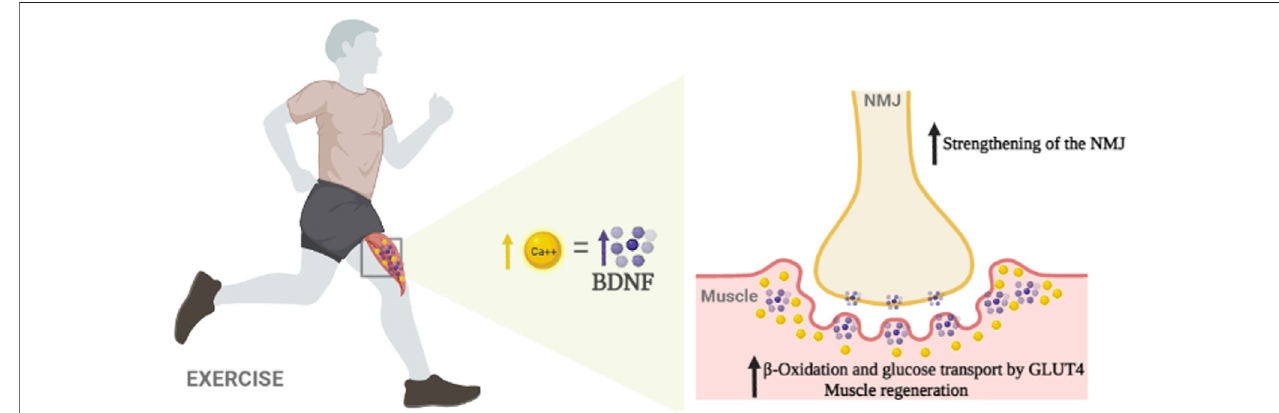
FIGURE1| Aschematicdiagram showing theputativeeffectsoftheBDNF synthesized bytheskeletalmuscle duringphysicalexercise. Ca++ seeminglyregulates this process. Once produced, the neurotrophin works autocrine and paracrine to strengthen the NMJ. In addition, the BDNF participates indirectly in muscle regeneration at sustaining the pool of satellite cells. Finally, the neurotrophin enhances fat metabolism ( β -oxidation) and facilitates glucose transport by increasing the GLUT4 transporter levels in the muscle.